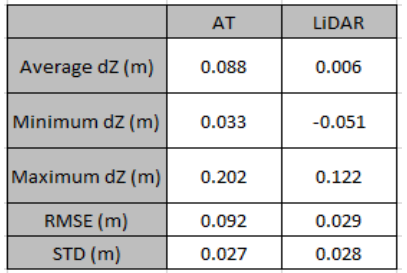
Table 4: Comparison of the CPs (vertically).